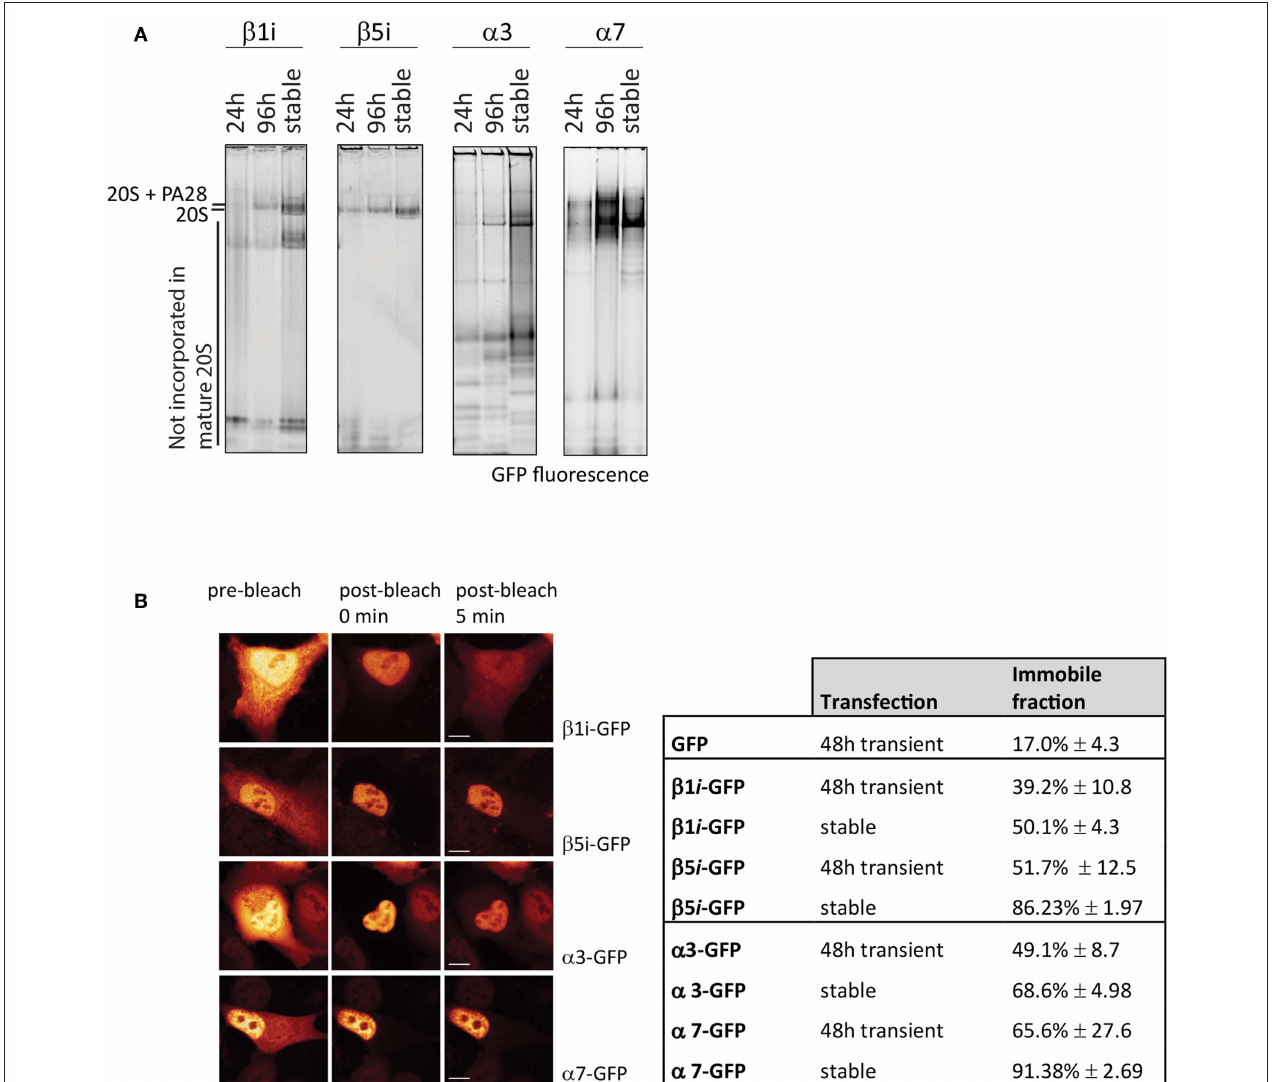
FIGURE 6 | Incorporation of GFP-tagged proteasome subunits. (A) Incorporation of transient and stably expressed proteasome subunits. The α -subunits α 3-GFP and α 7-GFP were expressed in U2OS cells and β 1i and β 5i were expressed in HeLa cells, either stable or transient for 24h or 96h. GFP-tagged subunits were identified by scanning for fluorescence. Stable expression of subunits α 3, α 7, and β 1i did not further improve incorporation when compared to 96h transient expression. (B) Fluorescence loss in photobleaching (FLIP) to distinguish non-incorporated from incorporated GFP-tagged subunits. By photobleaching the entire cytoplasm, the small GFP-tagged subunits that freely diffuse between nucleus and cytoplasm also become photobleached, while GFP-tagged proteasomes in the nucleus remain fluorescent. Cells, either transiently transfected for 48h or stably expressing the proteasome subunits, were analyzed for free diffusion of non-incorporated subunits by photobleaching the entire cytoplasm and quantifying the decrease in fluorescence in the nucleus. The immobile fraction is the remaining percentage of fluorescence in the nucleus, representing large GFP-tagged proteasome complexes. Nuclear fluorescence of β 1i-GFP and to a lesser extent α 3-GFP decreases in time, indicating a substantial non-incorporated pool of GFP-tagged subunits (mean ± SD, N = 5). Scale bar = 5 µ